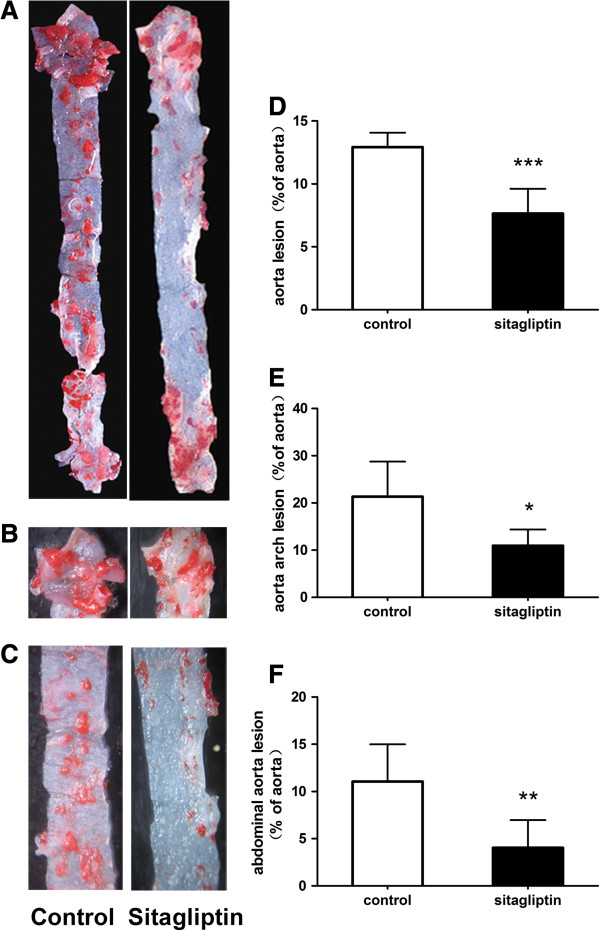
Atherosclerotic lesion formation in aortic sections from ApoE-/- mice. Sitagliptin reduced atherosclerotic lesion formation in ApoE-/- mice. (A) Aortic en face flat from the aortic root to the renal artery stained with Sudan IV. (B) En face flat of the aortic arch. (C) Aortic en face flat of the abdominal aorta. (D) Relative atherosclerotic lesion area of the atherosclerotic lesion to the whole aorta in the two groups. (E) Relative atherosclerotic lesion area in the aortic arch. (F) Relative atherosclerotic lesion area in the abdominal aorta. Data are mean ± SD, n = 6. *p < 0.05, **p < 0.01 versus control.